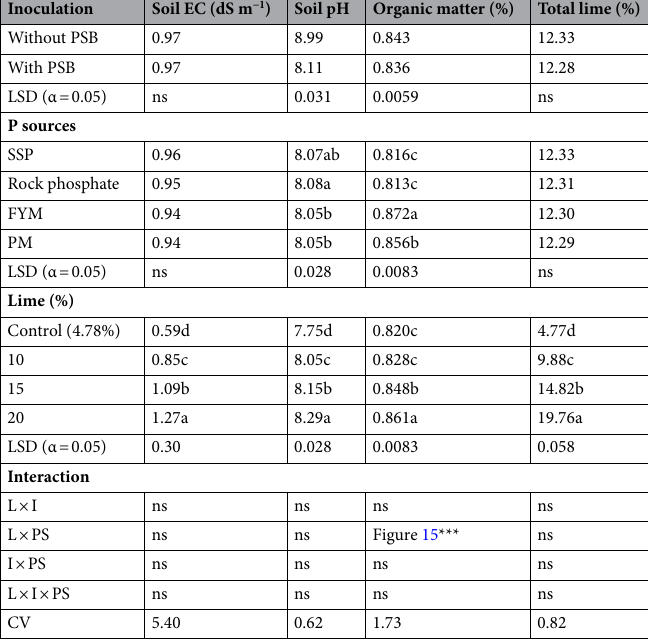
Table 6. Post-harvest (wheat) soil EC, pH, organic matter and lime contents as influenced by PSB, phosphorus sources under different lime levels. PSB, LSD, SSP, FYM, PM and ns denote phosphate solubilizing bacteria, least significant difference, single super phosphate, farmyard manure, poultry manure and non-significant interaction, respectively. Means with different letter in each column are significantly different at p ≤ 0.05. Triple asterisk stands for very higly significant.